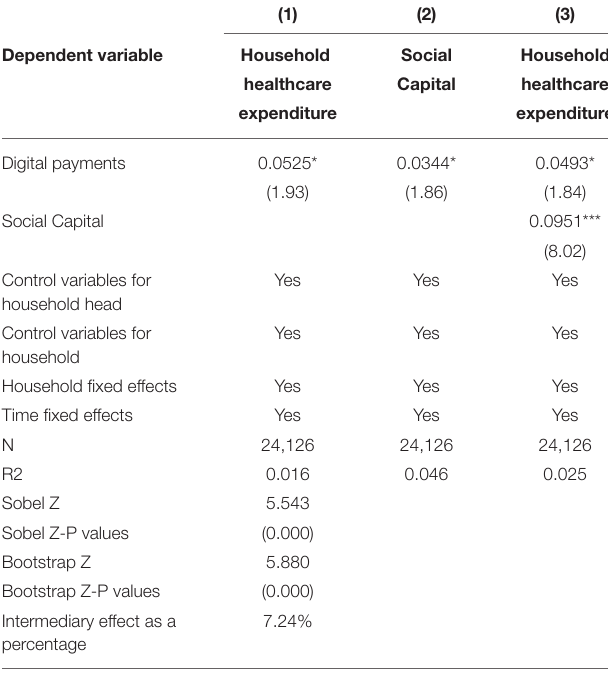
TABLE 8 | Mechanism analysis: social capital.